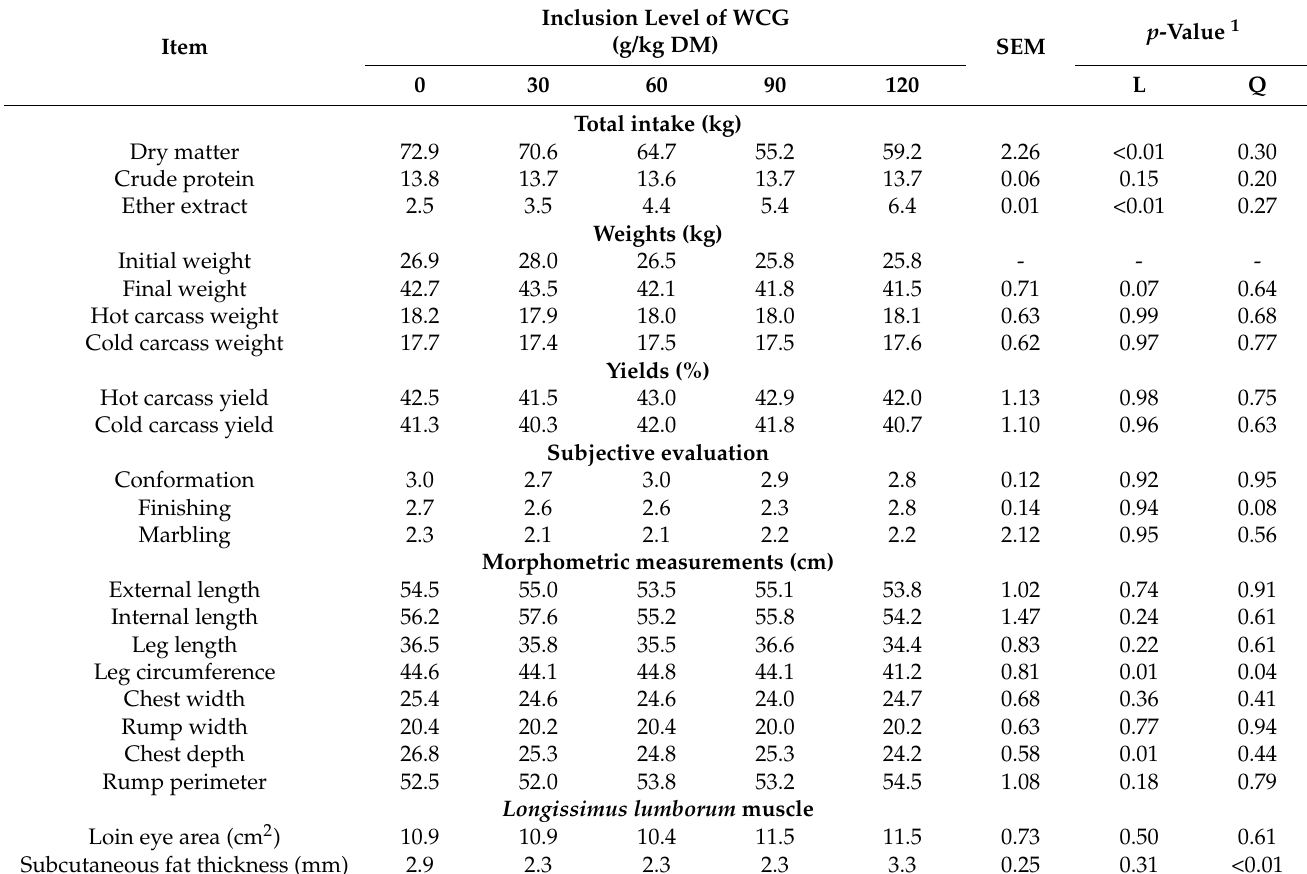
Table 2. Average nutrient intake during the experimental period, quantitative, subjective, and carcasses morphometric measurements of feedlot lambs fed diets with whole corn germ